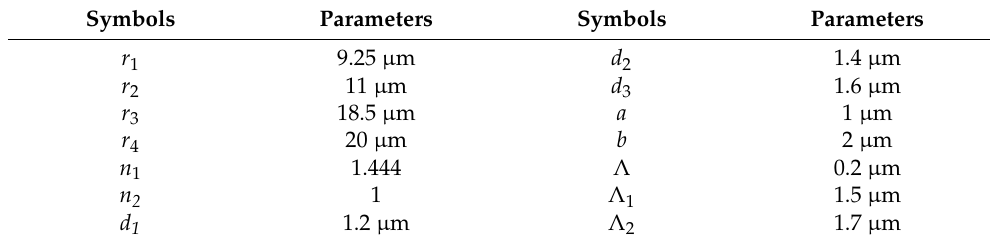
Table 2. The main parameters of SC-PCF. Symbols Parameters